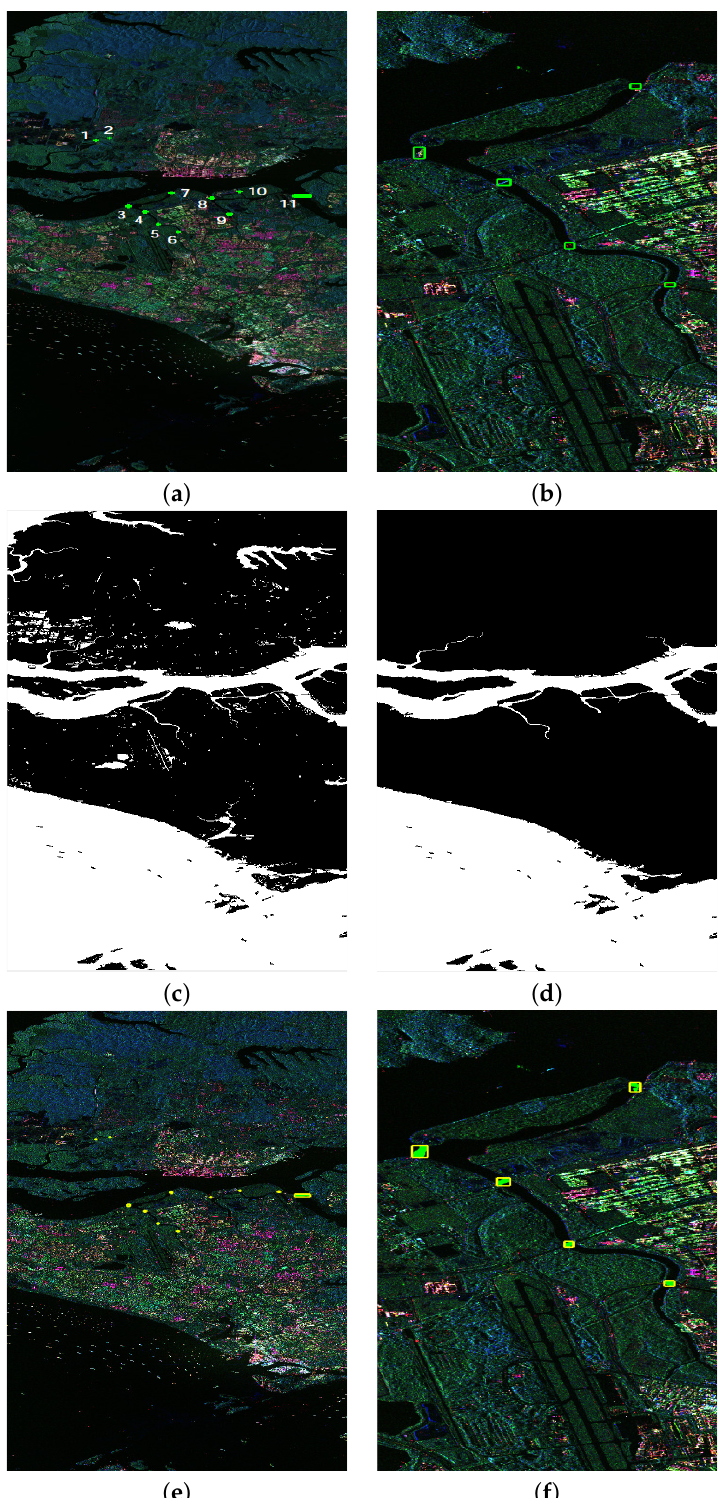
Figure 13. Bridge detection results of data from TerraSAR-X in Singapore: ( a ) the Pauli pseudocolor image and the ground truth of the bridges, where the bridges are marked by green boxes; ( b ) an enlarged view of part of the image ( a ) near a narrow tributary; ( c ) the water branch extraction result; ( d ) the water network connection result; ( e ) the bridge detection result; ( f ) the detection result of the enlarged part of ( b